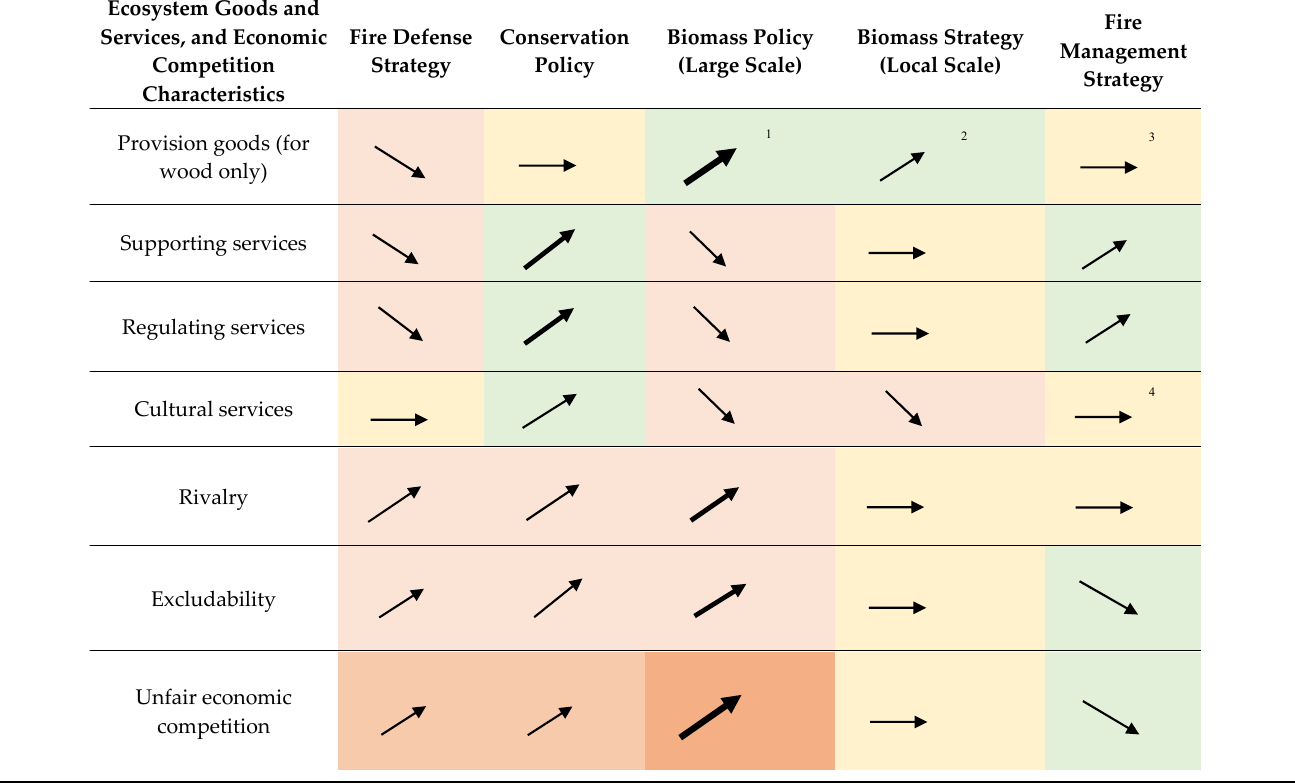
Table 3. Description of the different scenarios and the associated impacts on the four ecosystem service categories, and on the accessibility to forest goods and services. The different scenarios have been developed with stakeholders during participative workshop, and then specified by our analysis based on interviews and document analysis. The fire-defense and the conservation strategies have been described as business-as-usual scenarios, the biomass policy (at large and local scale) as the probable scenario, and the fire-management strategy as the desirable scenario by the majority of actors during participative workshops. Legend: the arrows indicate the increasing, decreasing or no change evolution of the characteristics listed in the first column (large arrow indicates a strong increase or decrease). The color of the cells indicates the desirable level according to the assessment of stakeholders during workshops (Dark green cells = extremely desirable for future, light green cells = desirable, yellow cells = no assessment or neutral, light red cells = no desirable, dark orange cells = extremely desirable).